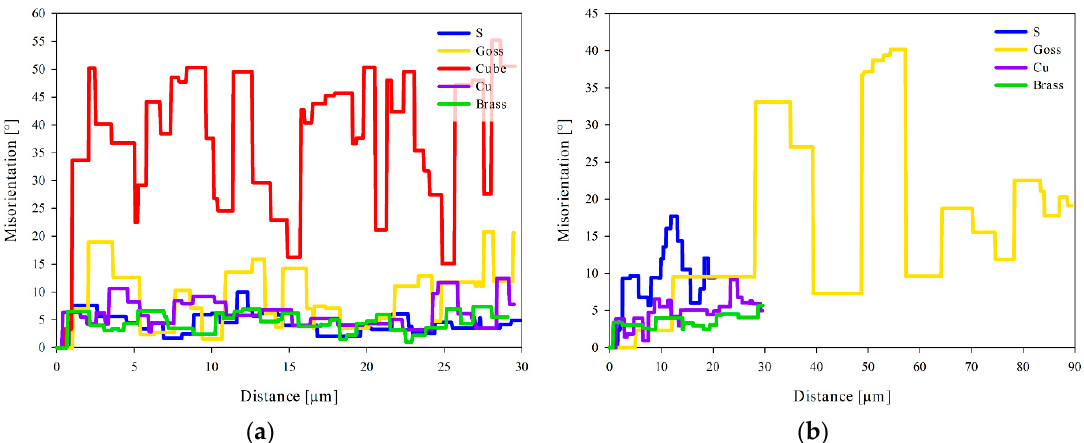
Figure 12. Misorientation gradients of various texture components from HP Al parallel to the ND-direction in the investigated RD-ND sections in as-deformed and annealed state. ( a ) As deformed. ( b ) Annealed at an elevated temperature for more than 24 h. (ND: Normal direction; RD: rolling direction).